Question: Does the plotted quantity increase or decrease?
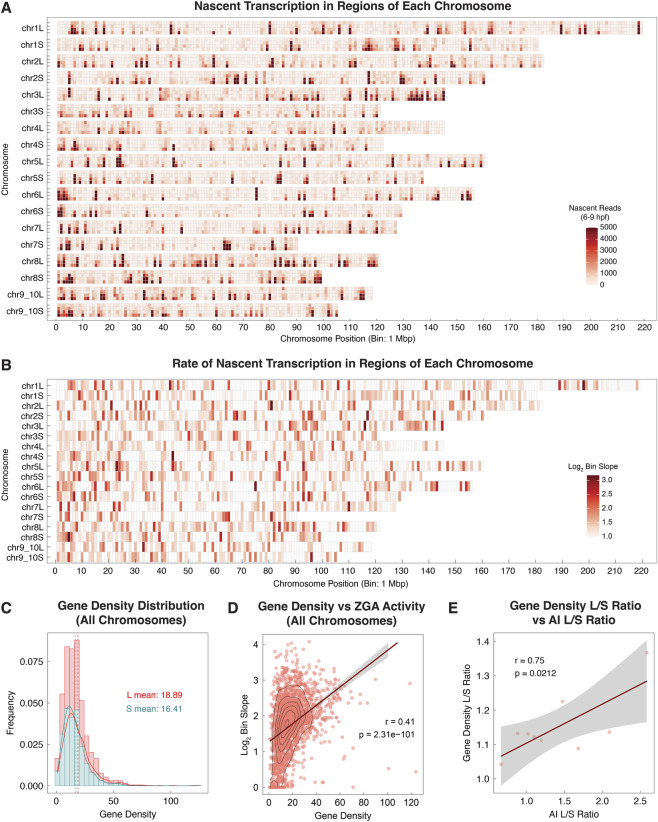
Answer: increasing